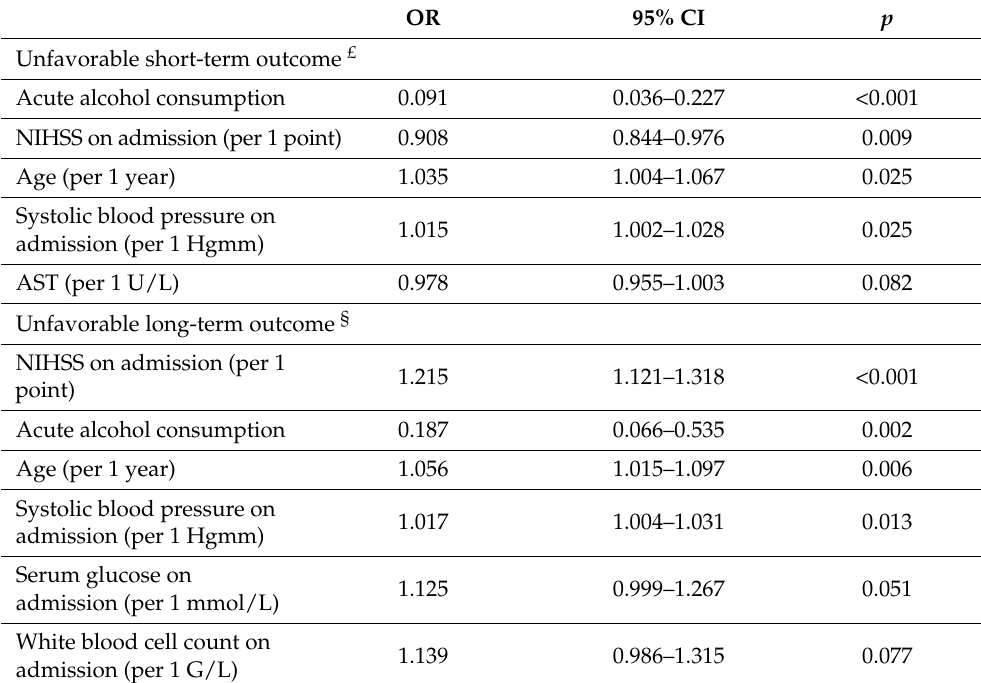
Table 3. Independent predictors for unfavorable short- and long-term outcomes of intravenous thrombolysis in the investigated cohort.